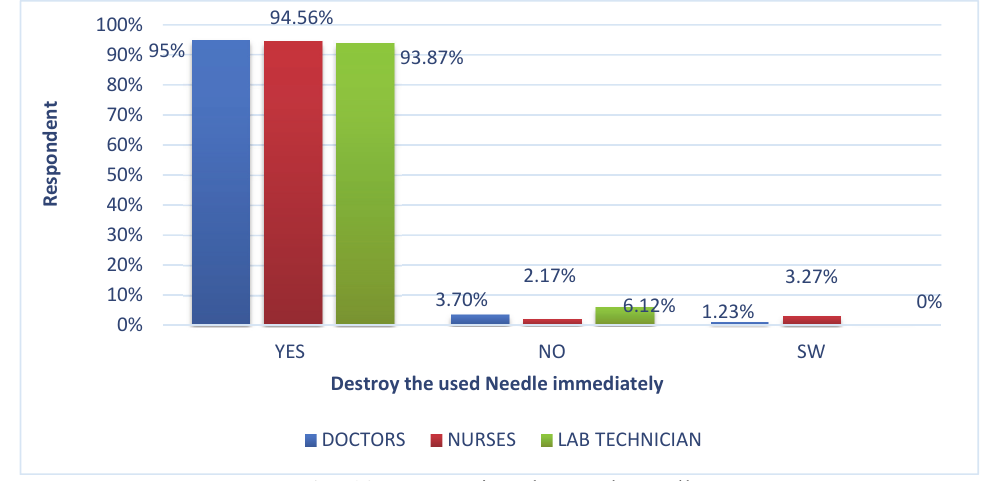
Fig. 10. Destroying the used Needle